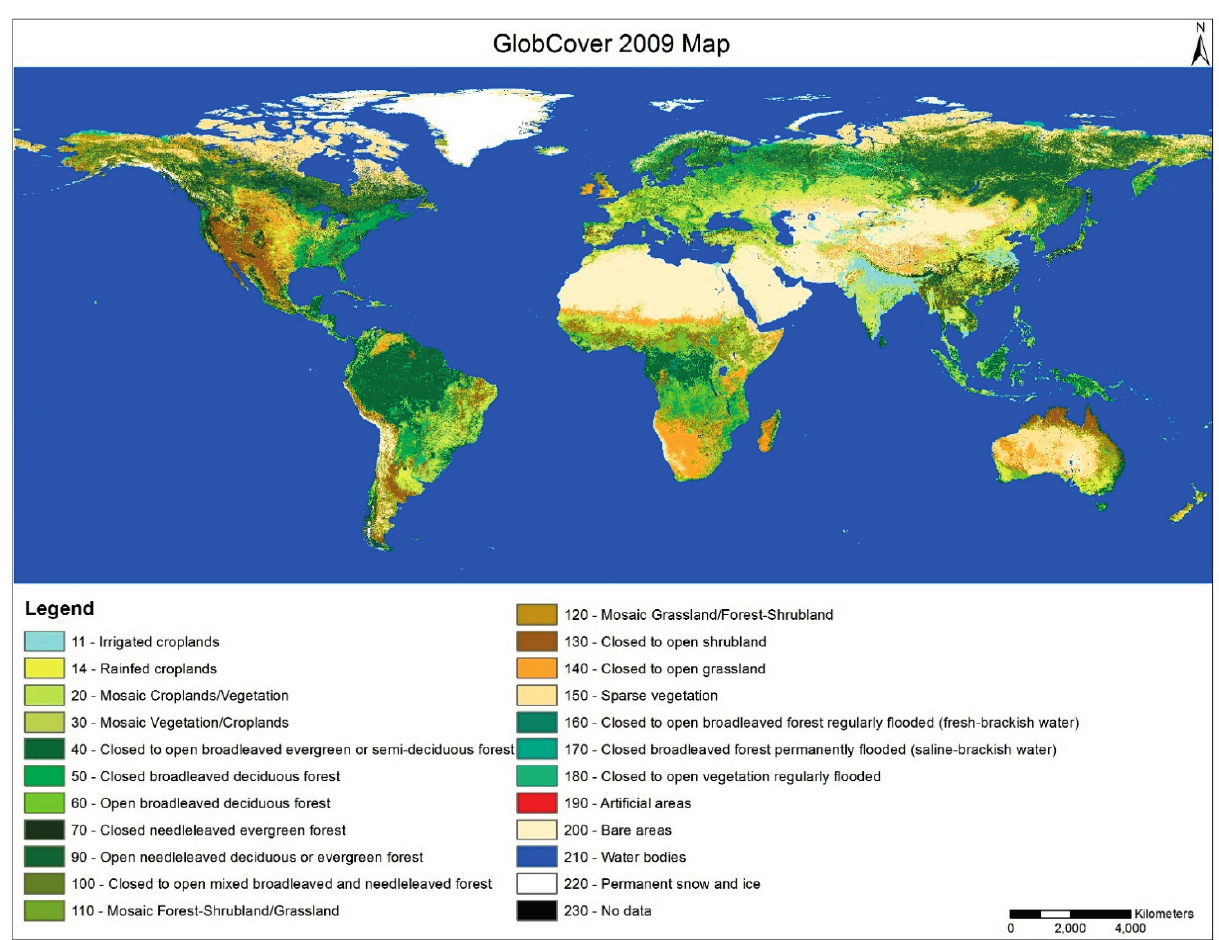
Figure 4. The GLOB Cover 2009 Land Cover Map (figure generated from data obtained at